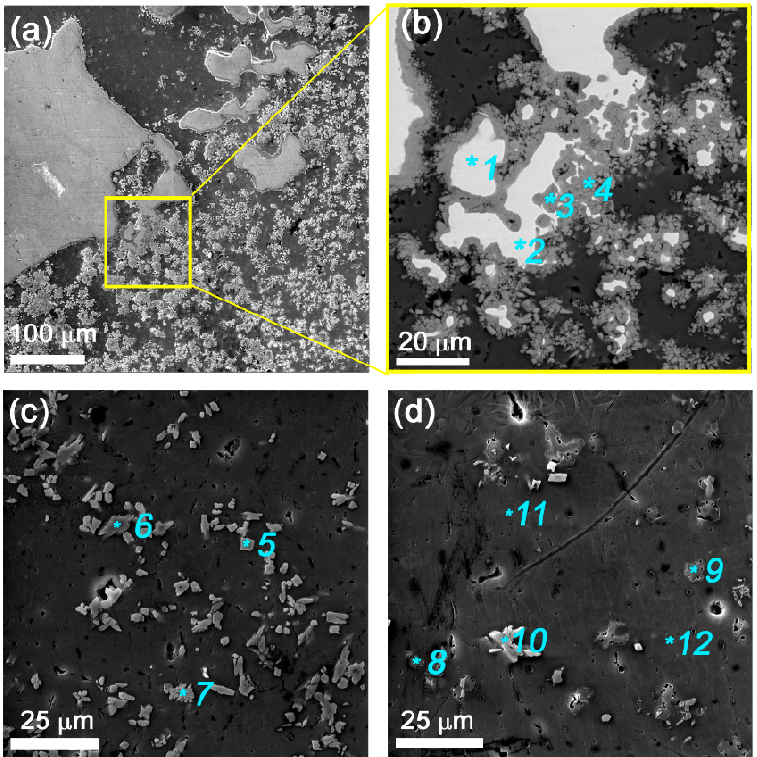
Figure 8. SEM BSE images of zone 2 AA5154/Mo microstructures obtained with 0.6 g/layer Mo ( a – d ). Numbers 1–11 denote point selected for EDS (Table 4). ( a – d ). Numbers 1–11 denote point selected for EDS (Table 4). Table 4. EDS analysis of the AA5154/Mo with 0.6 g/layer was obtained by using SEM (Figure 8b–d). Concentration of Elements, Spectrum